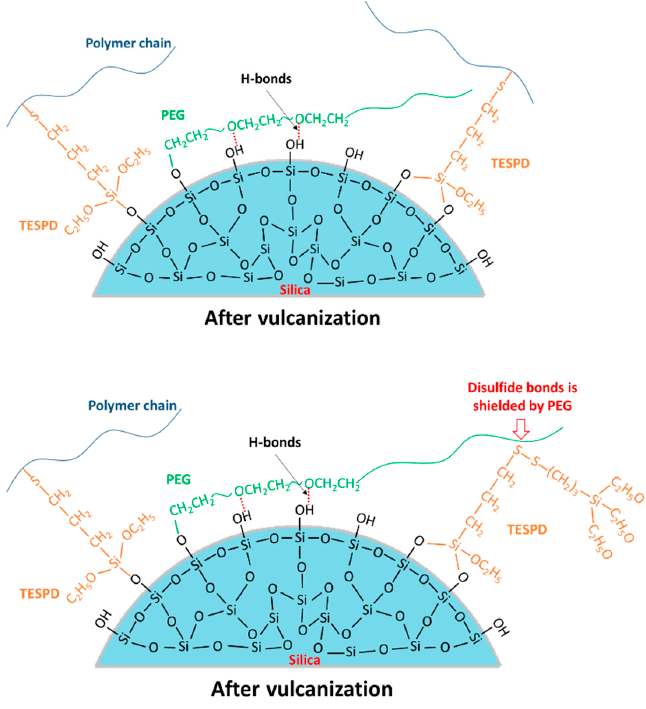
Figure 5. Schematic of the possible reaction mechanisms after vulcanization.